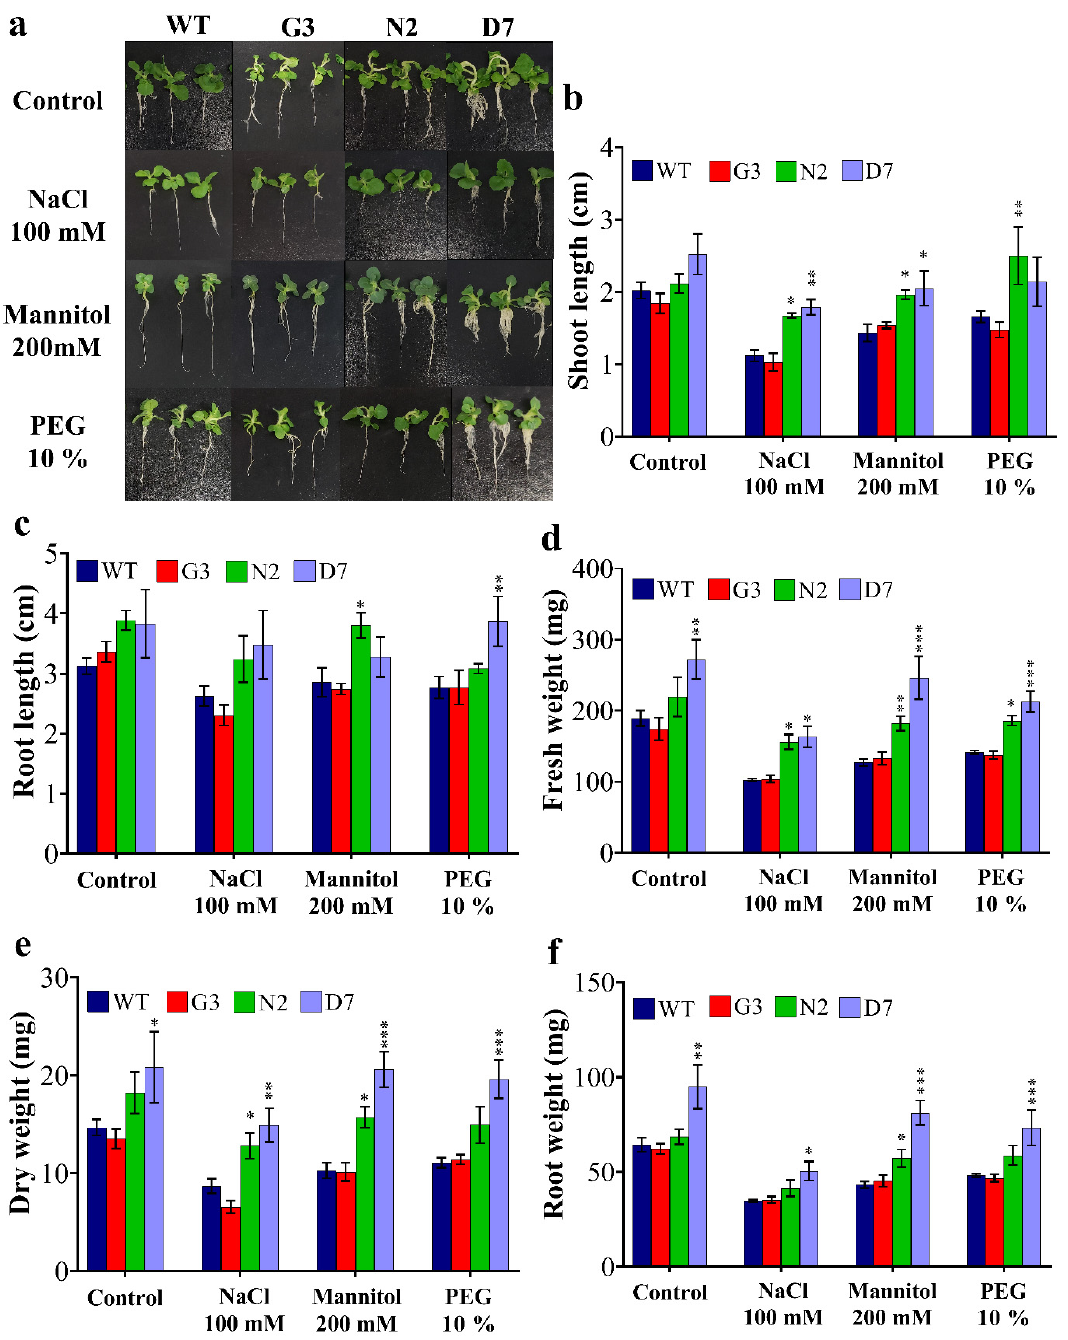
Figure 6. Morphology and growth characteristics of WT and transgenic lines as affected by different stress conditions. ( a ) Fourteen-days seedlings from WT and transgenic lines were grown in vitro for four weeks under control, 100 mM NaCl, 200 mM mannitol and 10% PEG. ( b ) Shoot length, ( c ) root length, ( d ) fresh weight, ( e ) dry weight and ( f ) root fresh weight. The bars represent mean values ± SEM of three biological replicates (four plants each). Asterisk(s) indicate(s) significant differences between the means of wild type (WT) and transgenic line of each treatment group at * p < 0.05, ** p < 0.01, *** p < 0.001 according to Dunnett test.